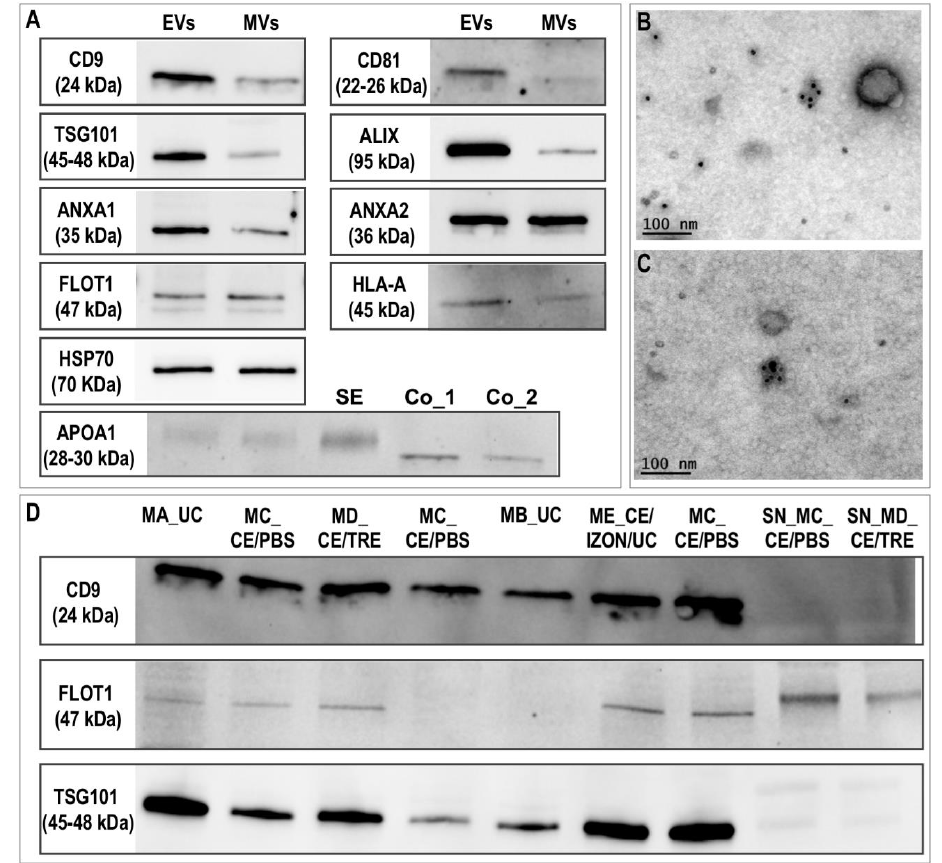
Figure 4. Characterization of equine uterine extracellular vesicles (EVs) protein profile. ( A ) Western blotting characterization of EVs and microvesicles (MVs; pellet after centrifugation of uterine lavage at 12,000 × g ) for known exosomal protein markers and apolipoprotein A1 (SE: Serum from mares; Co_1 and Co_2: Human apolipoprotein protein control 0.5 and 0.2 µg). ( B , C ) Representative images of electron microphotographs of CD9 immunogold labelling of EVs. ( D ) Western blotting comparison of EVs obtained by different methods for three known exosomal markers (CD9, FLOT1, and TSG101). MA_UC: EVs obtained by ultracentrifugation (UC) 100,000 g (2×) 90 min using fixed angle rotor and Beckman bottles; MB_UC: UC with swing-out rotor and Beckman tubes; MC_CE/PBS: ultrafiltration by using Centricon filters followed by a washing step with PBS; MD_CE/TRE: similar to before but washing step with PBS/25 mM trehalose; ME_CE/IZON/UC: obtained by the combination of CE, followed by SEC, Izon qEV columns and the collection of fractions enriched in EVs (7,8,9) and concentration of EVs fractions by UC; SN_MC_CE_PBS and SN_MD_CE_TRE: supernatant obtained after first UC from MC_CE/PBS and MD_CE/TRE.